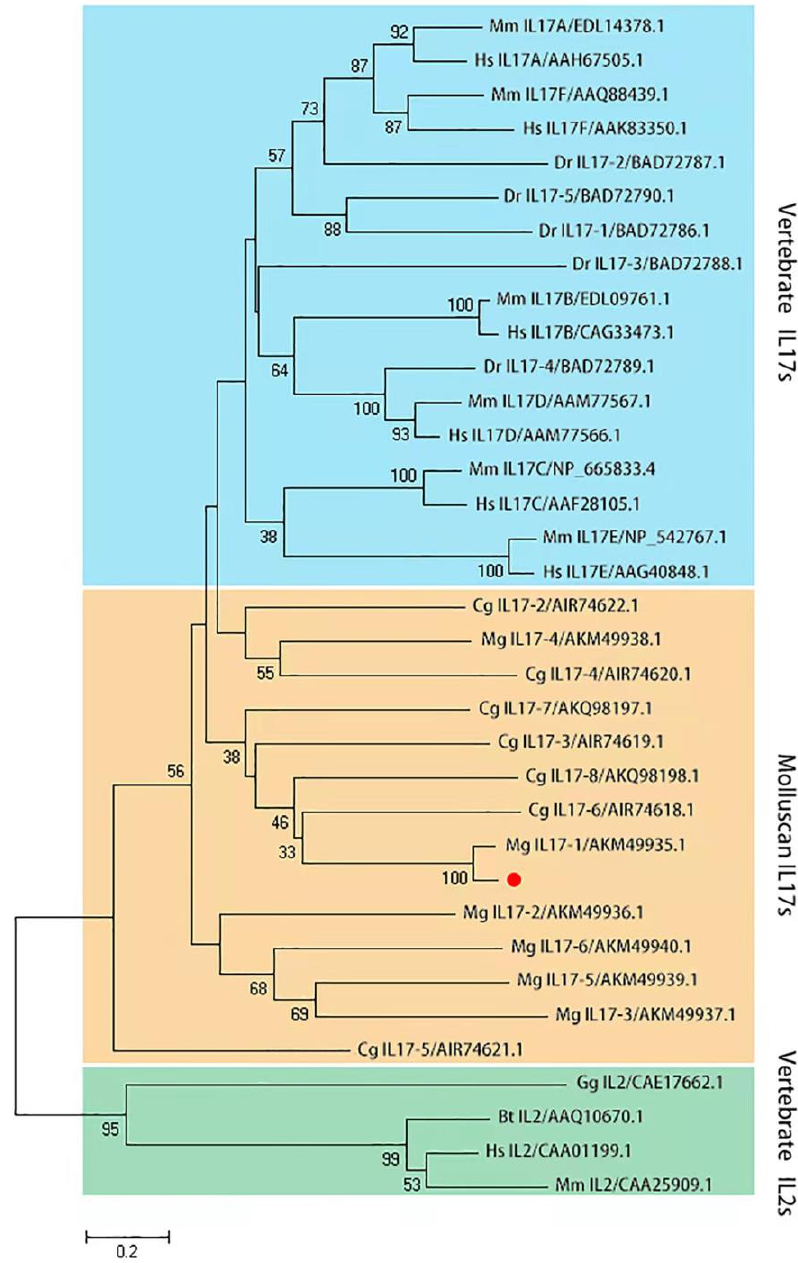
Figure 2. Phylogenetic analysis of Mc IL17-1. The phylogenetic tree is constructed using MEGA-X software with 2000 replications of bootstrap in the way of the neighbor-joining method. Mc IL17-1 is labeled with a red dot. Species included in the phylogenetic tree are all retrieved from the GenBank database and accession numbers are also listed in the tree. Sequences from various species are abbreviated as follows: Hs , Homo sapiens ; Mm , Mus musculus ; Bt , Bos taurus ; Dr , Danio rerio ; Gg , Gallus gallus ; Mg , Mytilus galloprovincialis ; Cg , Crassostrea gigas .